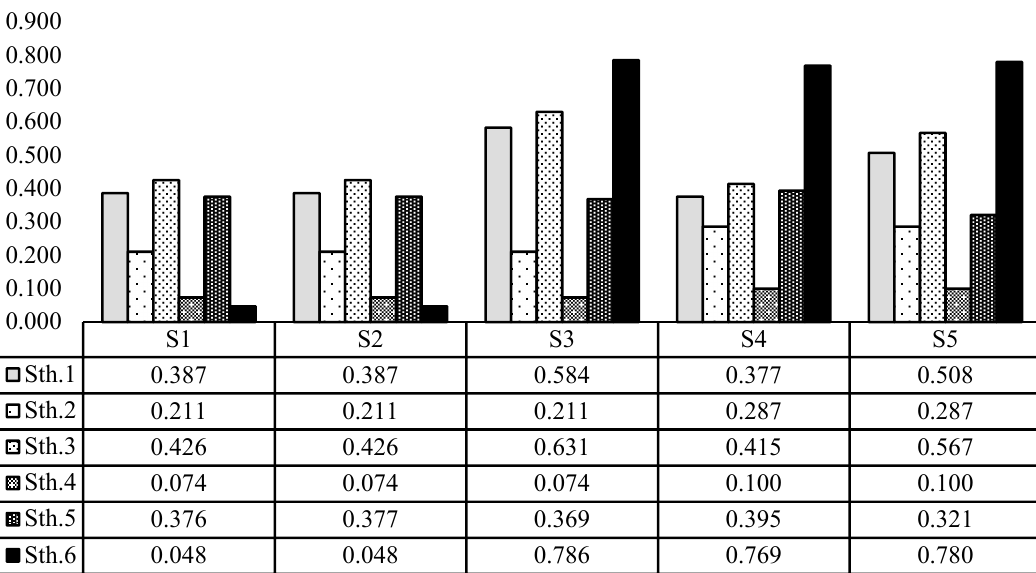
Figure 10. Scores of the water strategies in each stakeholder’s viewpoint (satisfying all criteria).